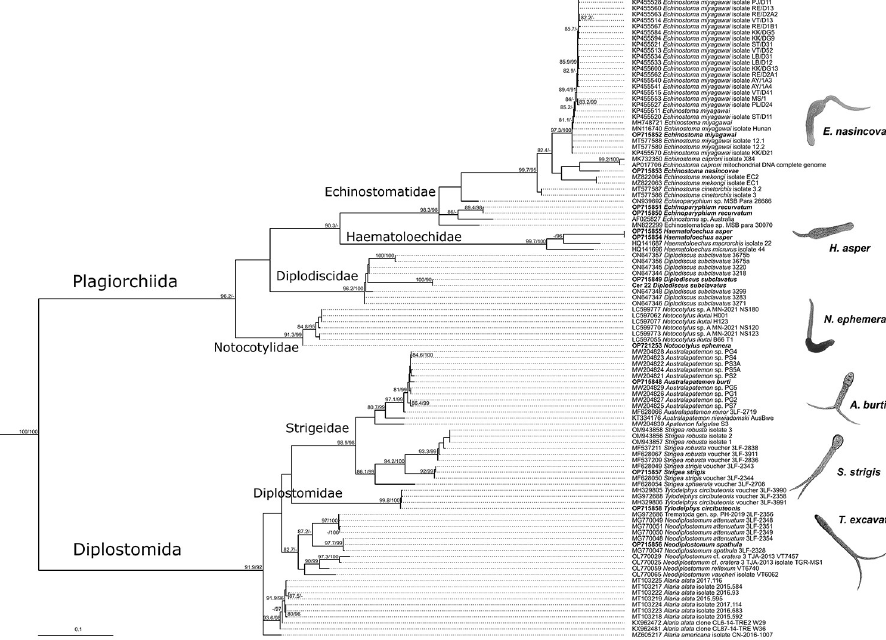
Fig 2. Phylogenetic relationship of trematodes based on COI sequences. Maximum-likelihood phylogenetic tree of trematode species inferred using IQ-TREE with 1,000 SH-like approximate likelihood ratio test (SH-aLRT) and ultra- fast bootstrap (UFboot) replicates each. AM913860, AM913862 and AM913865 Polystoma are used as an outgroup. iNumbers at nodes indicate SH-aLRT support ( � 80%)/UFboot support ( � 95%); values less shown with “-”.